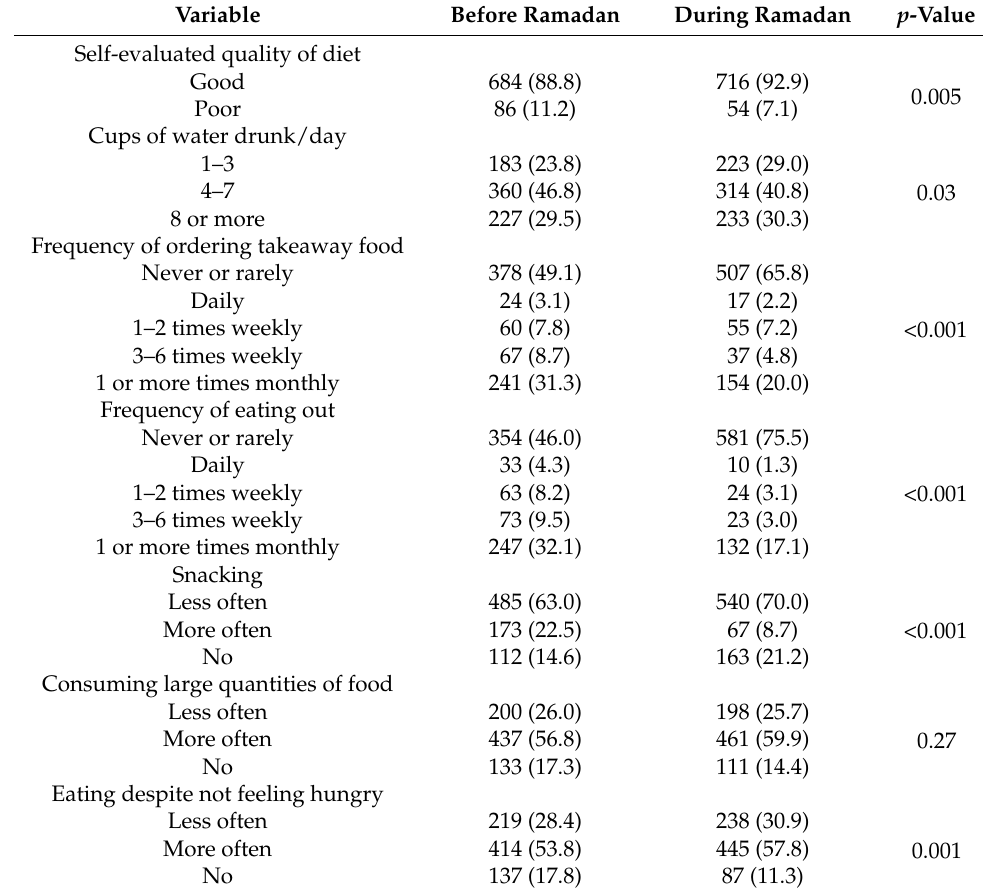
Table 2. Diet quality and eating behaviors before and during Ramadan.